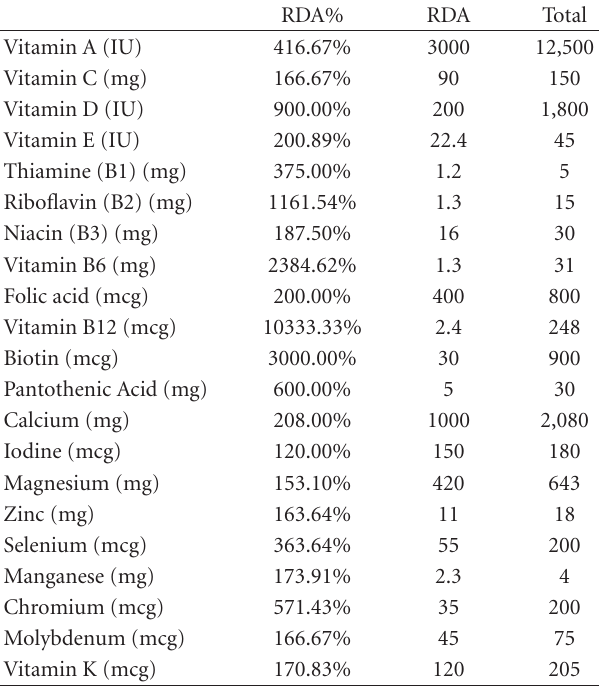
Table 2: Summary of individual ingredients in supplements that exceeded recommended daily allowance (RDA) in this case.